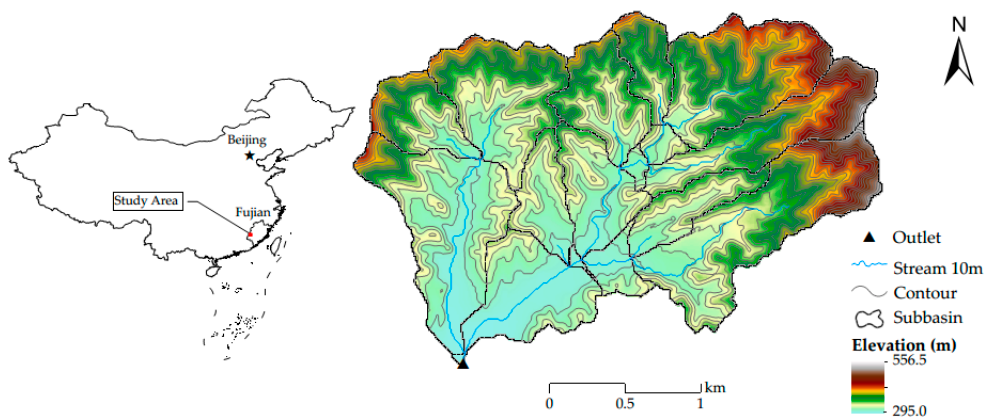
Figure 3. Map of the Youwuzhen watershed in Fujian Province, China (adapted from [2] ).